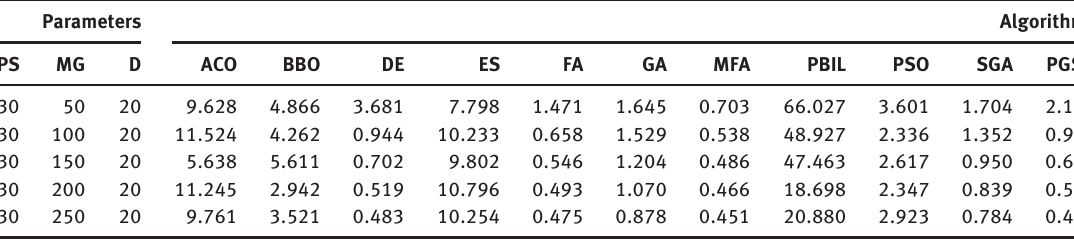
Table 5. Best Optimization Results on Different Evolutionary Generations. Para meters